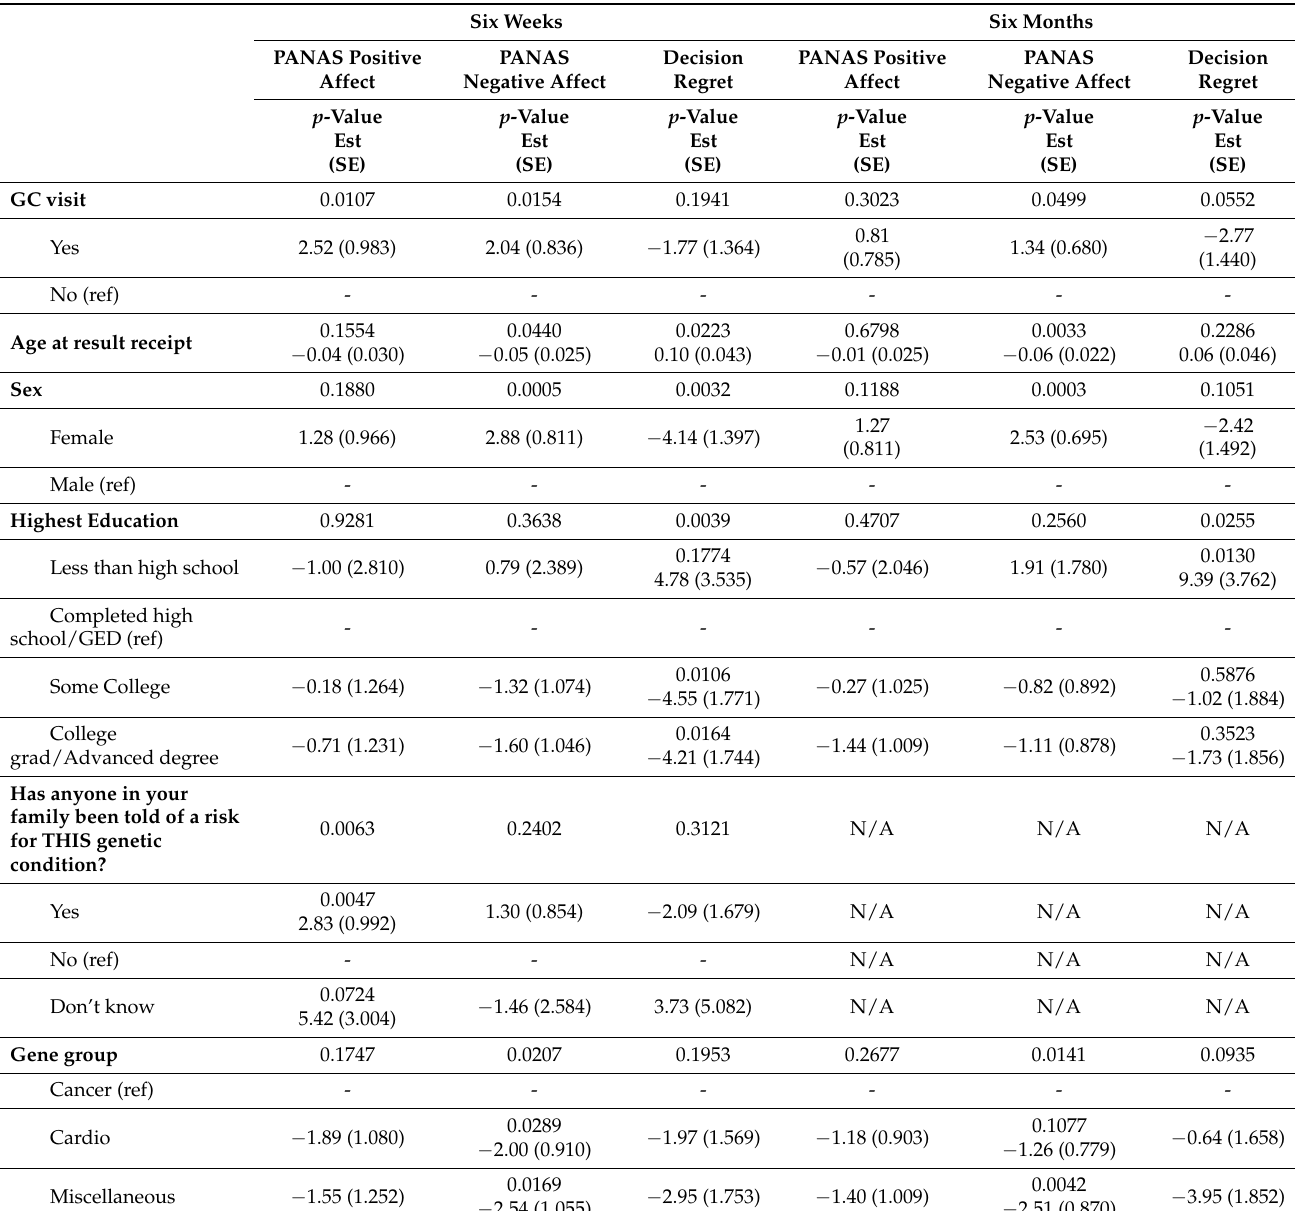
Table 4. General linear model estimates for the Decision Regret, Positive and Negative Affect (PANAS) scales at 6 weeks and 6 months. Six Weeks Six Months PANAS Positive PANAS Decision PANAS Positive PANAS Decision Affect Negative Affect Regret Affect Negative Affect